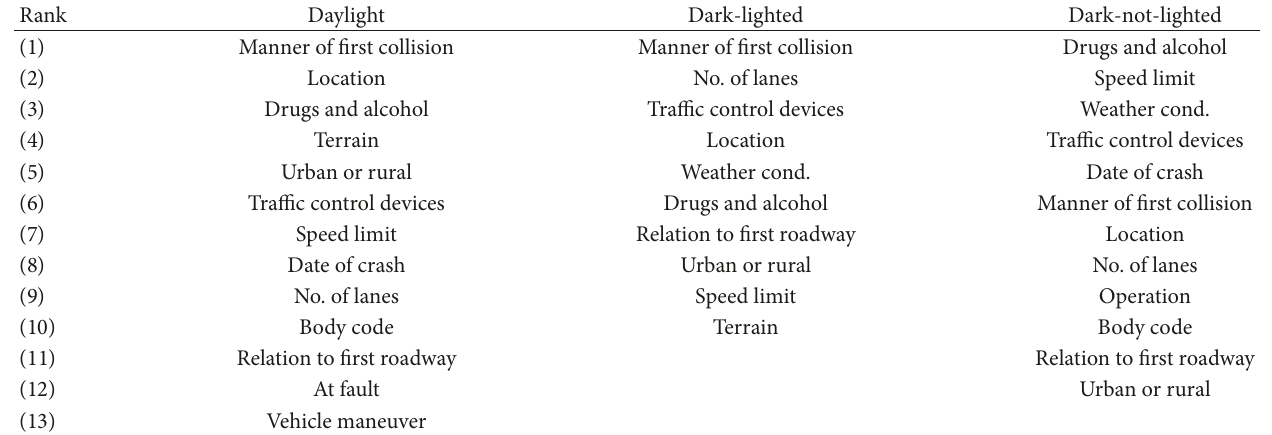
Table 5: Rank of the importance of variables under different light conditions.